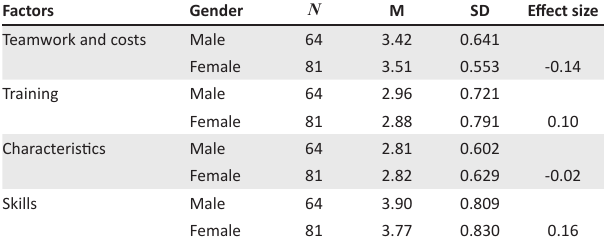
TABLE 4: Comparison of mean scores between males and females. Factors